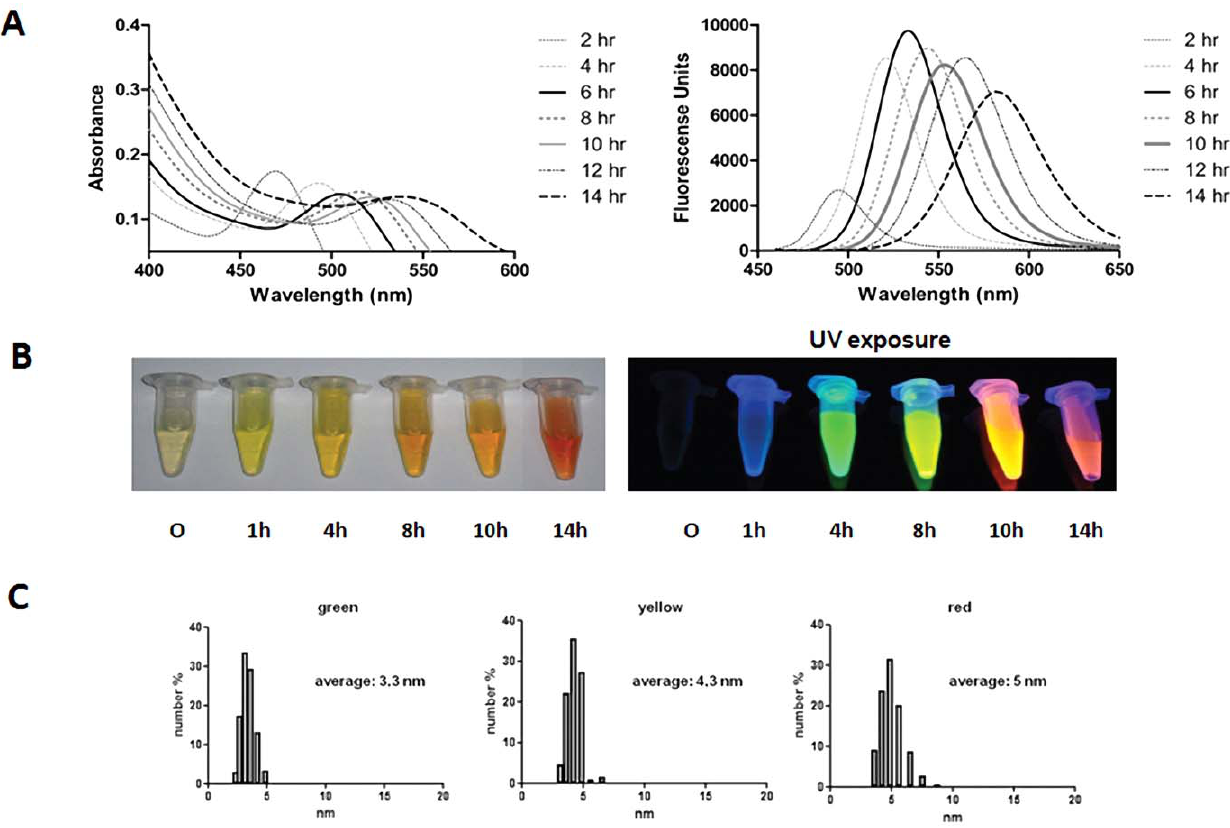
Figure 1. Absorbance and fluorescence emission spectra of CdTe-GSH QDs synthesized at 90 6 C. A, samples were withdrawn at the indicated times. B, fluorescence of the as-produced CdTe-GSH QDs at the indicated times of synthesis and excited with UV light at 312 nm. C, Dynamic Light Scattering (DLS) analysis of green, yellow and red CdTe-GSH nanoparticles.